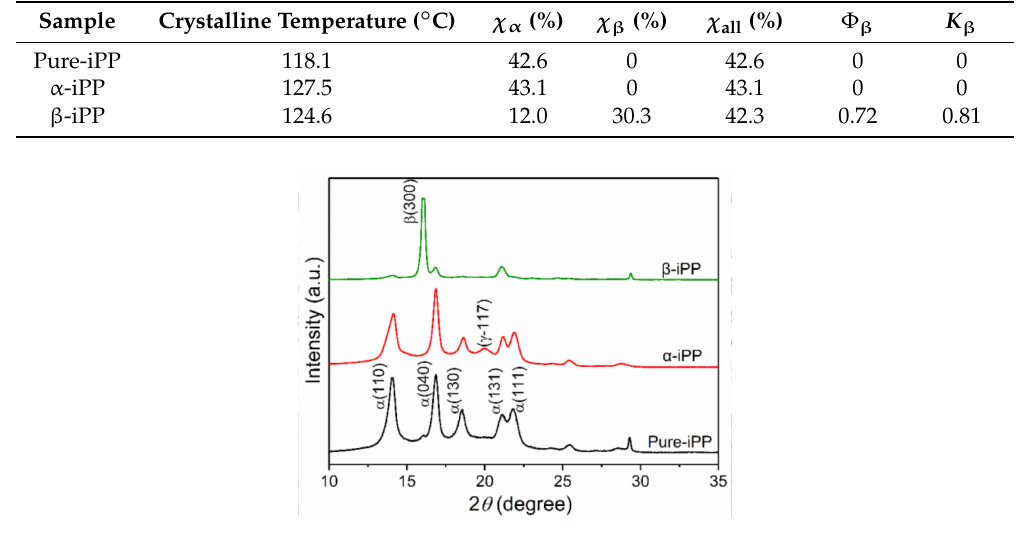
Figure 2. XRD patterns of iPP samples.